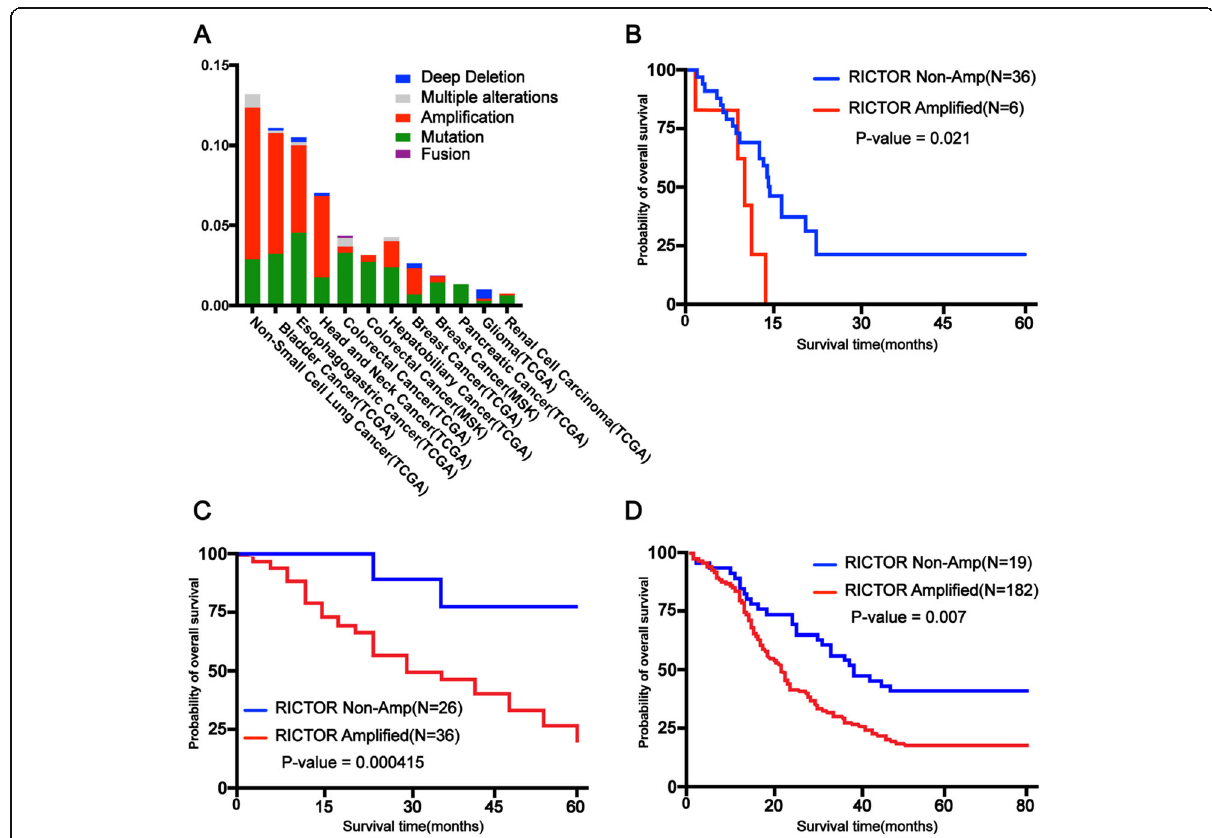
Fig. 2 Alteration frequency and clinical outcome of RICTOR amplification in different cancers ( a Alteration frequency of RICTOR amplification in different cancers. b Kaplan-Meier plot on overall survival in SCLC patients with/without RICTOR amplification. c Kaplan-Meier plot on overall survival in colorectal cancer patients with/without RICTOR amplification. d Kaplan-Meier plot on overall survival in esophageal squamous